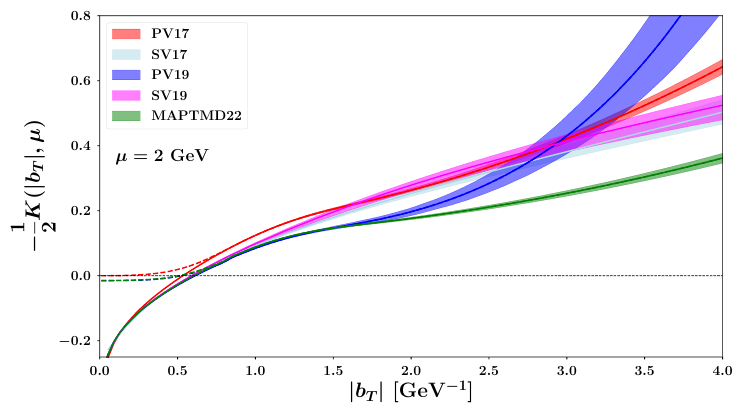
at a scale µ = 2 GeV from the present b T | | -prescription (see min